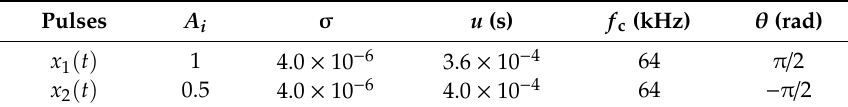
Table 1. Parameters of Gabor pulses x 1 ( t ) and x 2 ( t )